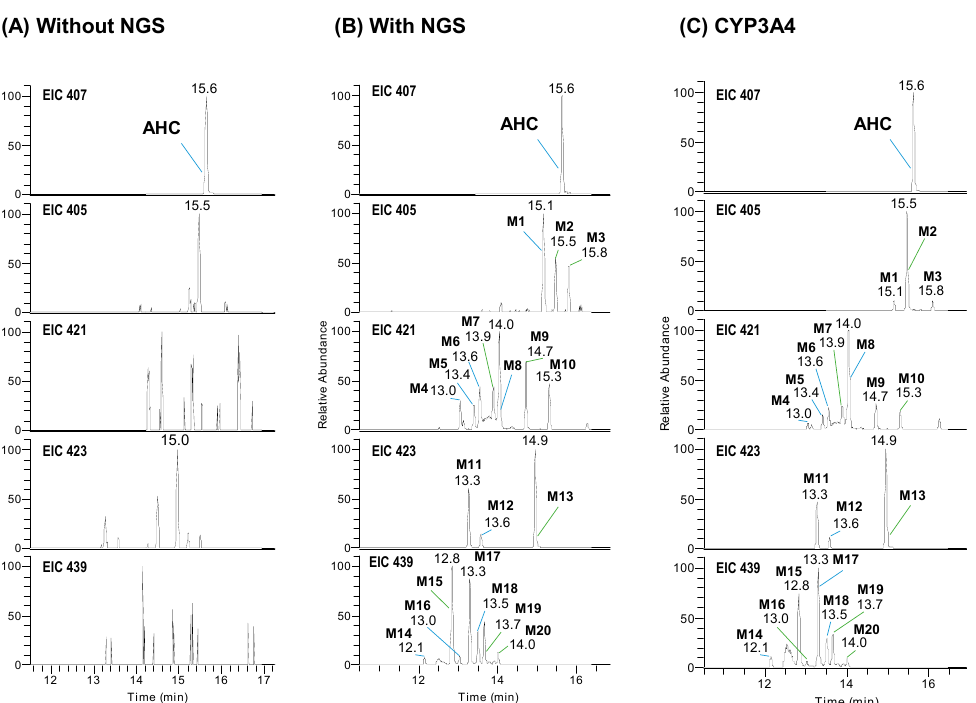
Figure 2. Extract ion chromatograms (EIC) for anhydrocinnzeylanine (AHC) and its metabolites. AHC (10 µ M) was incubated with 1 mg/mL pooled human liver microsomes for 60 min in the absence ( A ) or presence ( B ) of the β -NADPH- regenerating system (NGS). Synthesis of AHC metabolites by recombinant cDNA-expressed CYP3A4 after incubation at 37 ◦ C for 60 min ( C